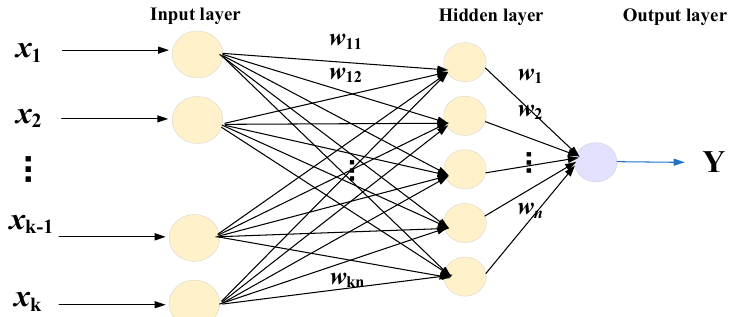
Figure 4. BP neural network structure.